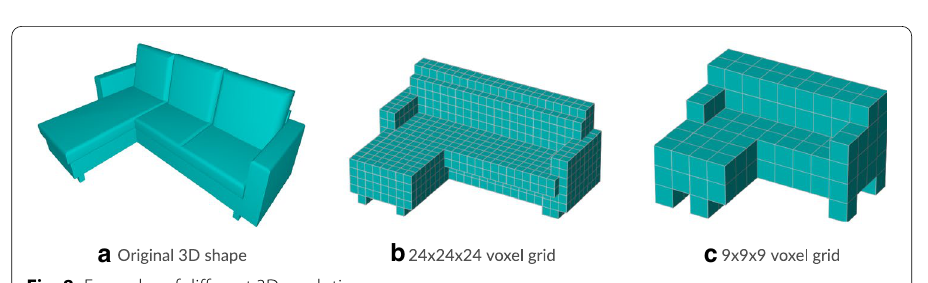
Fig. 8 Examples of different 3D